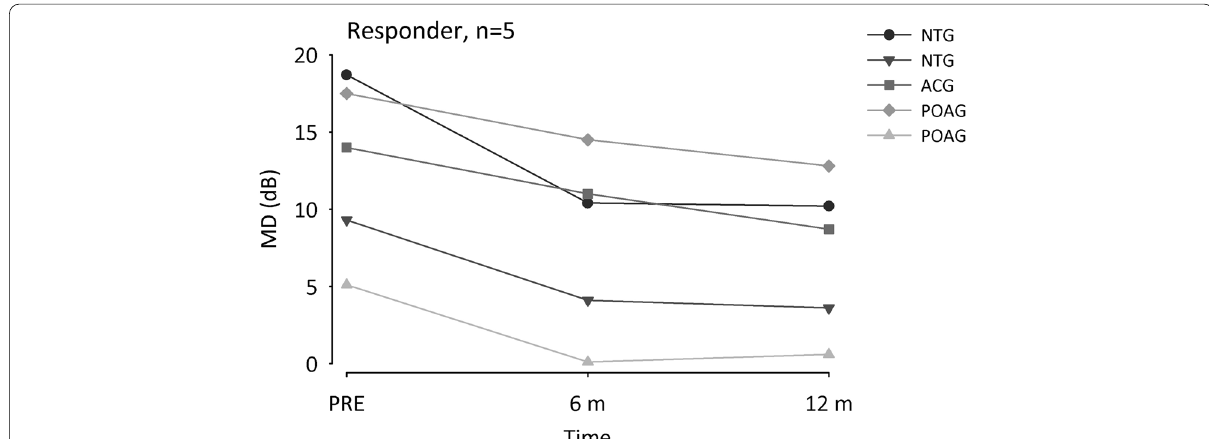
Fig. 2 Line graphs of mean defect (MD) in five responders before optic nerve stimulation (PRE), and 6 and 12 months after treatment. Patients suffered from primary open-angle glaucoma (POAG), normal tension glaucoma (NTG), or angle-closure glaucoma